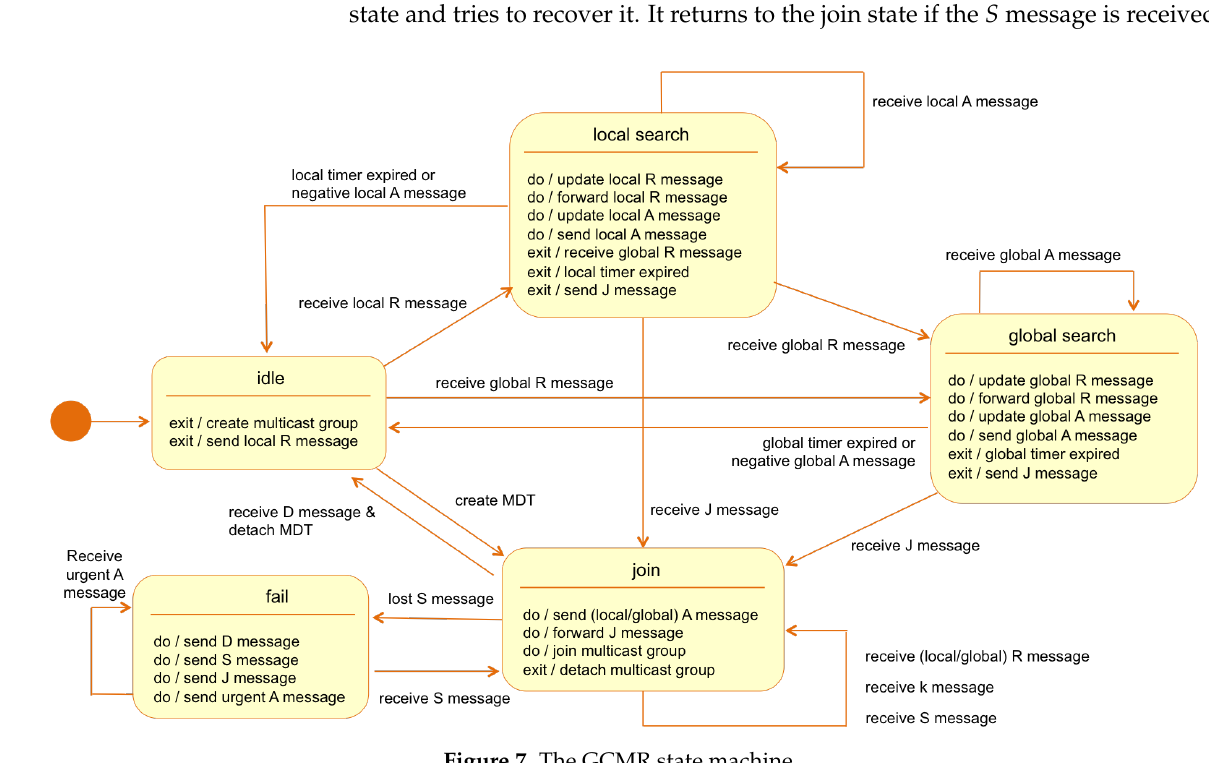
Figure 7. The GCMR state